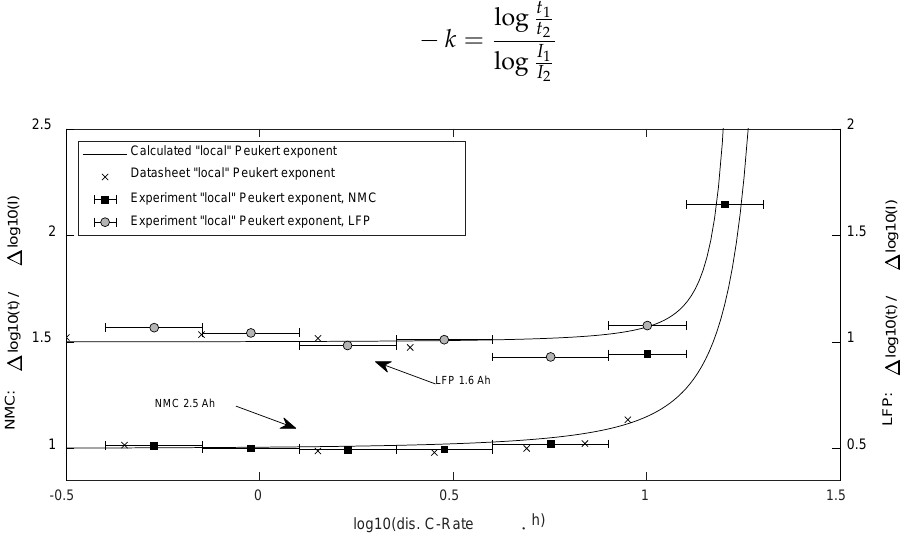
Figure 5. “local” mean Peukert exponents, which are valid for a specific span of discharge current as presented by the bars.